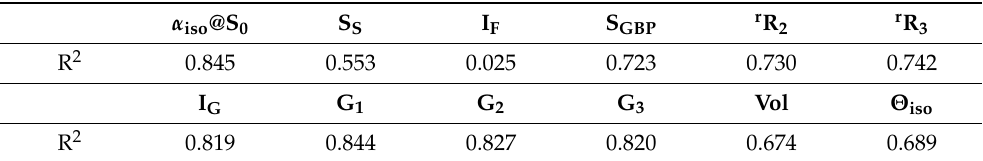
Table 3. Correlation coefficients (R 2 ) between the α iso @S 1 (in Bohr 3 ), and α iso @S 0 (in Bohr 3 ), ITA quantities@S 0 (in a.u.), molecular volume Vol@S 0 (in Bohr 3 /mol), and the isotropic quadrupole moment Θ iso @S 0 (in a.u.) for all the systems in Schemes 1 and 2.